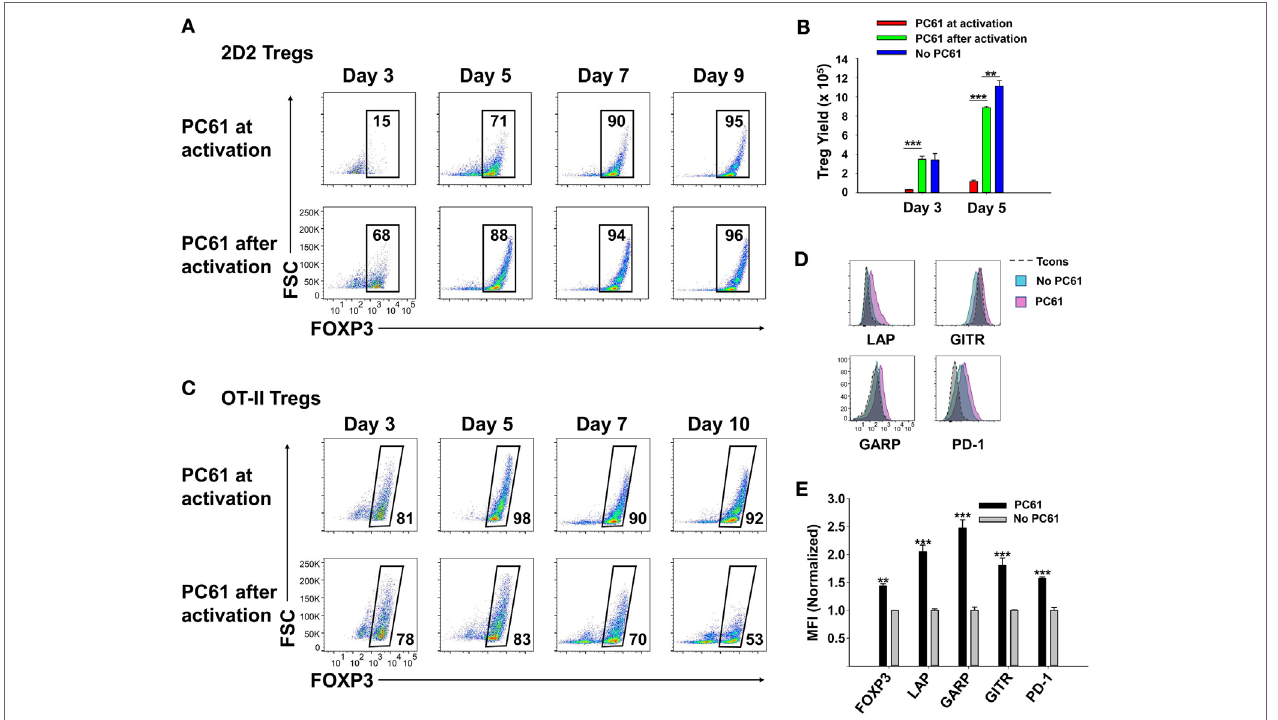
FigUre 3 | PC61 allowed for rapid generation of pure regulatory T cell (Treg) lines. 2D2-FIG splenocytes (SPL) (a,B,D,e) or OTII-FIG SPL (c) were activated at a density of 2 × 10 6 cells/ml in cRPMI with MOG35-55 (1 µM) or 100 nM OVA323-339, respectively, with 10 nM TGF- β in the presence or absence of 10 µg/ml PC61. Antigen and TGF- β were present only in the initial 3-day activation culture and not thereafter. (a–c) PC61 was (PC61 at activation) or was not (PC61 after activation) included in the initial 3-day activation culture but was included in both groups after passage of the cells on day 3. Cells were counted and then analyzed to determine percentages of viable, V β 11 + (2D2), V β 5.1 + (OTII), FOXP3 + T cells on the designated days. (B) Shown are the 2D2-FIG Treg yields on days 3 and 5. (D,e) After 3 days of activation with or without PC61, 2D2-FIG T cells were passaged for 10 days at a density of 10 6 cells/ml in rat IL-2 in the presence or absence of 10 µg/ml PC61. Cells gated as V β 11 + FOXP3 + Tregs or FOXP3 − conventional T cells (Tcons) were analyzed for expression of latency-associated peptide (LAP), GARP, GITR, and PD-1 on day 10 post-activation. MFI Values were normalized so that values obtained from T cells cultured in the absence of PC61 was equal to 1. These experiments are representative of three independent